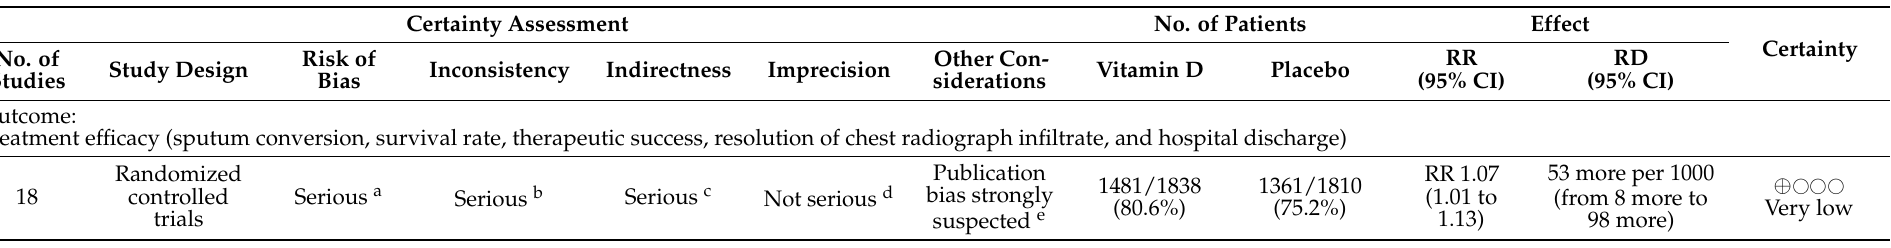
Table 4. Certainty of evidence and summary of findings based on the GRADE